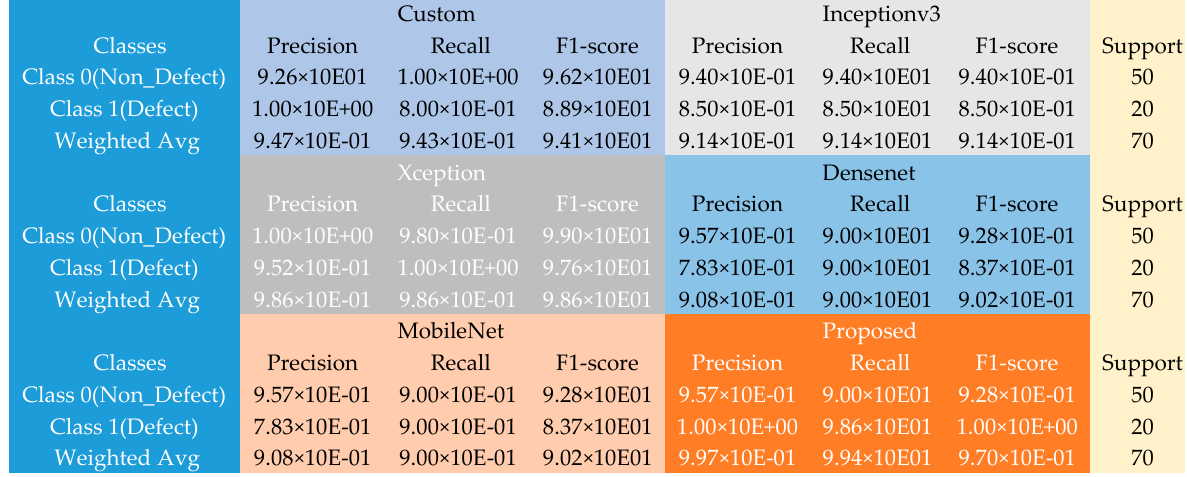
The results obtained from the experiments involving this dataset are shown in Table 4. models, with Kp scores of 9.98 × 10 − 1 , 1.00 × 10 +00 MCC, and 1.00 × 10 +00 accuracy. It also returned the least MSE of 6.70 × 10 − 6 and MSLE of 7.80 × 10 − 8 , returned the least MSE of 6.70 × 10 − 6 and MSLE of 7.80 × 10 − 8 , respectively. Table 4. The classification report for each of the models and the final model using the casting da- taset. Kp